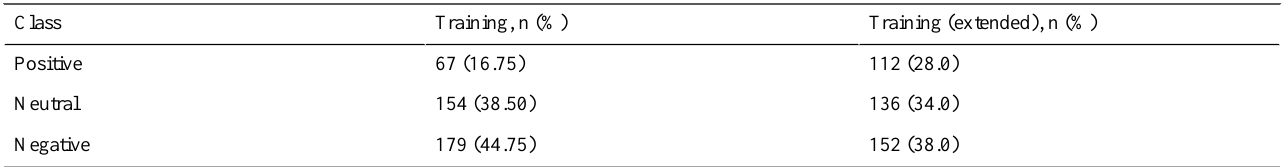
Table 2. Training data summary